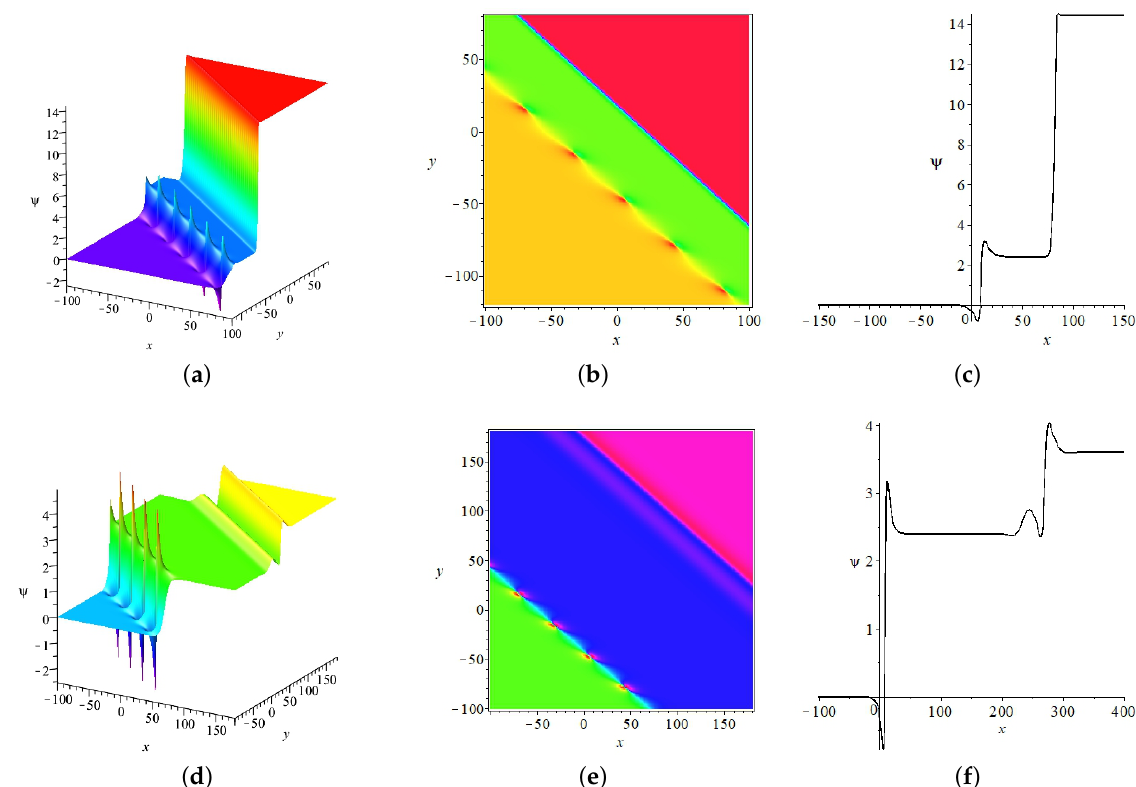
Figure 8. (Color online) The transformation of two-breather with r 2 = r 3 = r 4 = r 6 = r 7 = r 8 = 1, a 2 = 0.2, b 2 = 0, c 2 = 1.2, d 2 = 1, e 2 = 2 , f 2 = − 2 , β 1 = β 3 = 2, κ 1 = κ 2 = 0, γ 1 = − 20, γ 2 = 10. 3 3 In ( a ), a 1 = 1, b 1 = 0.1, c 1 = 1.2, d 1 = 0, e 1 = 1.5, f 1 = − 2.5. In ( d ), a 1 = 0.1, b 1 = 0.1, c 1 = 1.2, d 1 = 0, e 1 = 0.5, f 1 = − 3.5. These two figures are three-dimensional stereograms of two-breather transformation when t = 0, z = 0. ( b , e ) are the corresponding contour figure. ( c , f ) show the wave moves along the x axis when y = − 50, t = 0, z =